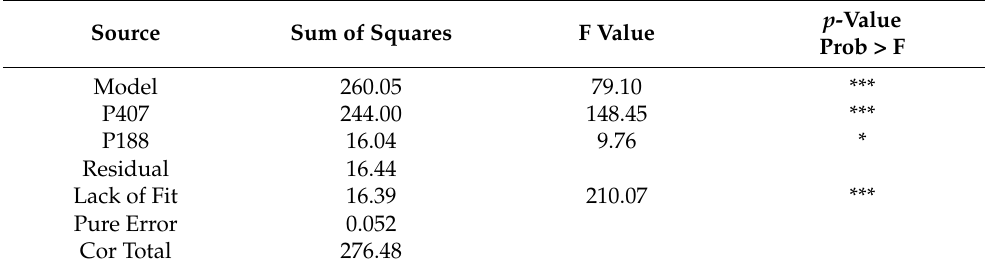
Table 3. The model parameters.